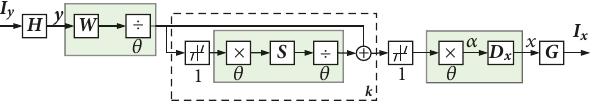
Figure 4: Process of middle mapping stage S 2